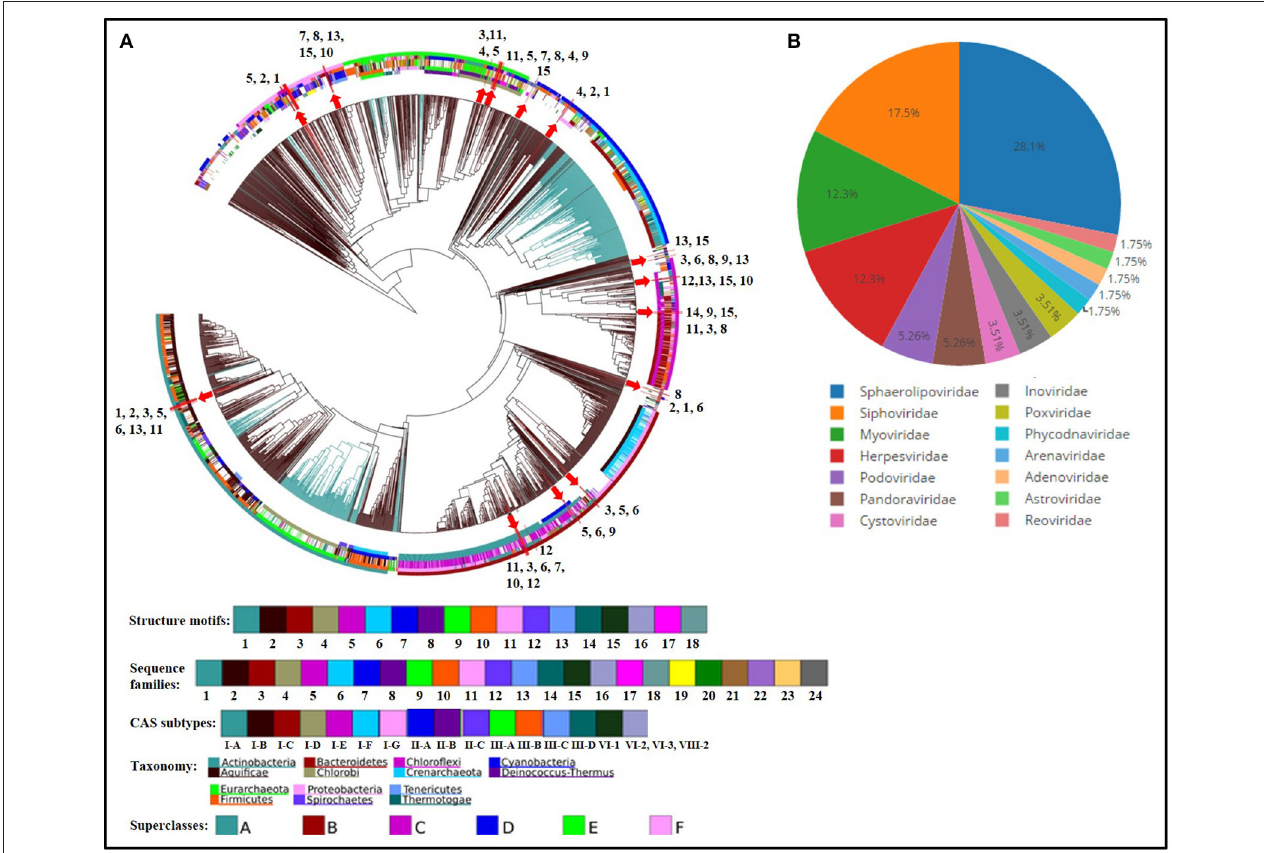
FIGURE 7 | CRISPR repeat (A) and spacer (B) analyses. (A) Dendrogram depicting clustering of CRISPR array repeats from all genomes of Thermus spp. against CRISPR repeats database (4,719 consensus repeats). The classification of repeats is based upon the division of all repeats into 24 conserved sequence families and 18 conserved structural motifs. The position of branches representing repeats from Thermus spp. is marked by red arrows and depicted by a number which corresponds to a genome, as follows: 1. T. aquaticus , 2. T. amyloliquefaciens , 3. T. brockianus , 4. T. caliditerrae , 5. Thermus sp. CCB_US3_UF1, 6. T. filiformis , 7. T. thermophilus HB8, 8. T. thermophilus HB27, 9. T. igniterrae , 10. T. thermophilus JL-18, 11. T. oshimai , 12. T. scotoductus , 13. T. tengchongensis , 14. T. parvatiensis , 15. T. thermophilus SG0.5JP17-16. Concentric circles are color coded and represent the following from inside out respectively: Structure motifs, sequence families, CAS subtypes, taxonomic groups, superclasses. Black and blue color branches represent bacterial and archaeal sequences respectively. (B) Pie diagram representing the relative abundance of viral families infecting Thermus genomes, predicted on the basis of CRISPR spacer analysis.